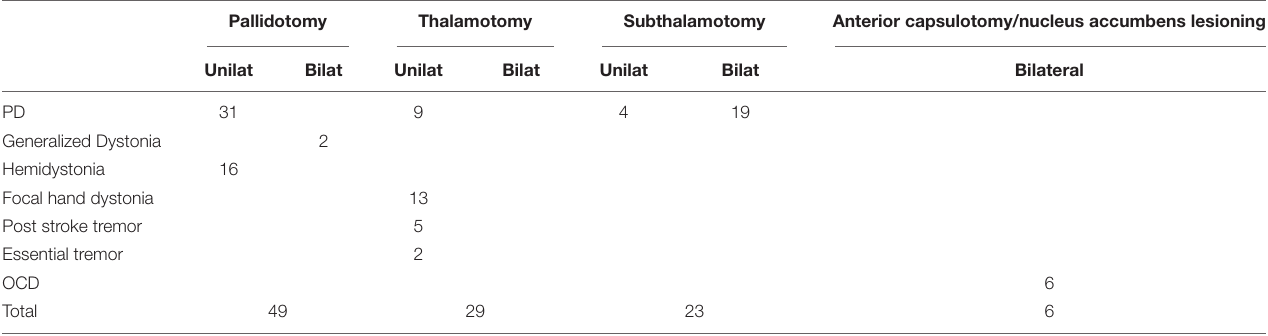
PD, Parkinson’s disease; OCD, obsessive-compulsive disorder; Unilat, unilateral; Bilat, bilateral.